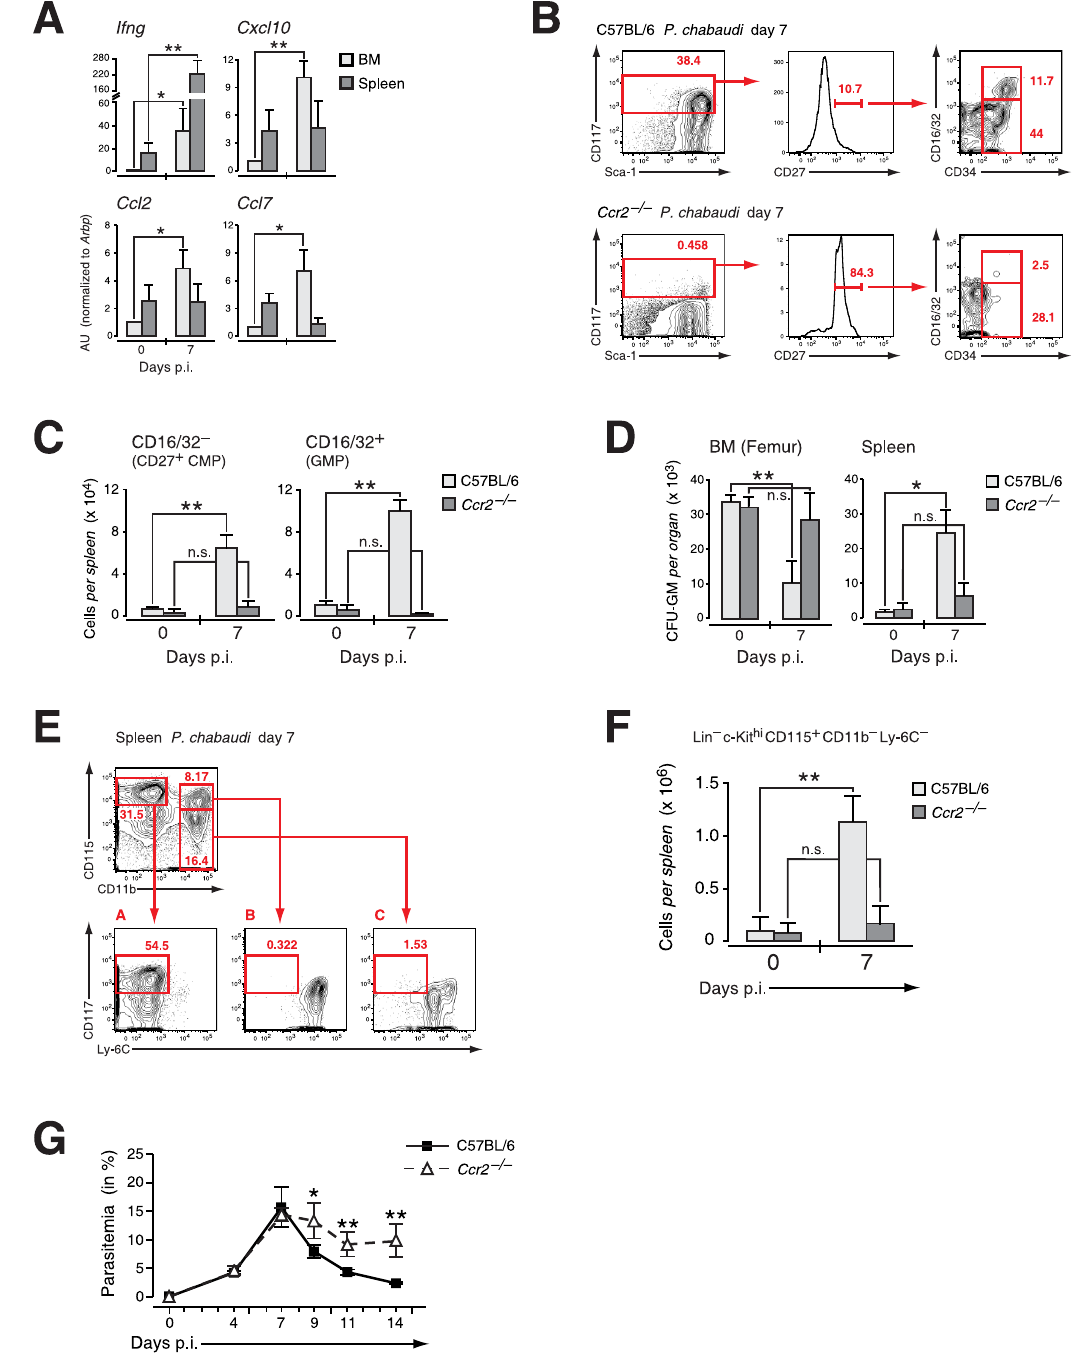
Figure 7. Extramedullary myelopoiesis in malaria is established by mobilizing CCR2 + myeloid-restricted BM progenitors. A. Expression of message for Ifng and IFN- c induced chemokines in organ samples from pre-immune and mice infected with P. chabaudi at day 7. Three to four individual organ samples each were obtained from two independent experiments and analyzed by RT-PCR. B. Phenotype of LIN 2 cells in the spleen of C57BL/6 and Ccr2 -null mice at day 7 after infection with P. chabaudi stained for indicated marker. Results in B.–E. are obtained form three infection experiments with 4–5 mice per group each. C. Absolute numbers of LIN 2 c-Kit hi CD27 + CD16/32 2 (CD27 + CMPs) and CD16/32 + (GMPs) cells in the spleen of C57BL/6 and Ccr2 -null animals in steady state or at day 7 after infection with P. chabaudi as quantified by flow cytometry. Results are shown as mean 6 SEM from three independent experiments with 4–5 animals per group (**: P # 0.01, Mann-Whitney U-test). D. Changes in the absolute number of clonogenic myeloid progenitors (CFU-GM) in the BM and the spleen in uninfected mice and at day 7 after infection with P. chabaudi . Data for Ccr2 -null mice and controls were obtained in three experiments with 4–5 samples per experiment and shown as mean 6 SEM of total number of CFU-GM per organ (*: P # 0.05, **: P # 0.01, two-tailed Student’s t -test). E. Phenotype of intrasplenic myeloid precursors during acute infection with P. chabaudi . Lineage-negative (Ter-119, CD3, CD11c, CD19, NK1.1) cells were stained for CD11b versus CD115 (M-CSF receptor) allowing the resolution of early myeloid precursors as c-Kit hi Ly-6C 2 . F. Absolute numbers of early myeloid precursors (LIN 2 c-Kit hi CD115 + CD11b 2 Ly-6C 2 ) in the spleen of uninfected mice and at day 7 after infection. Representative staining and splenic cellularity were obtained from three independent